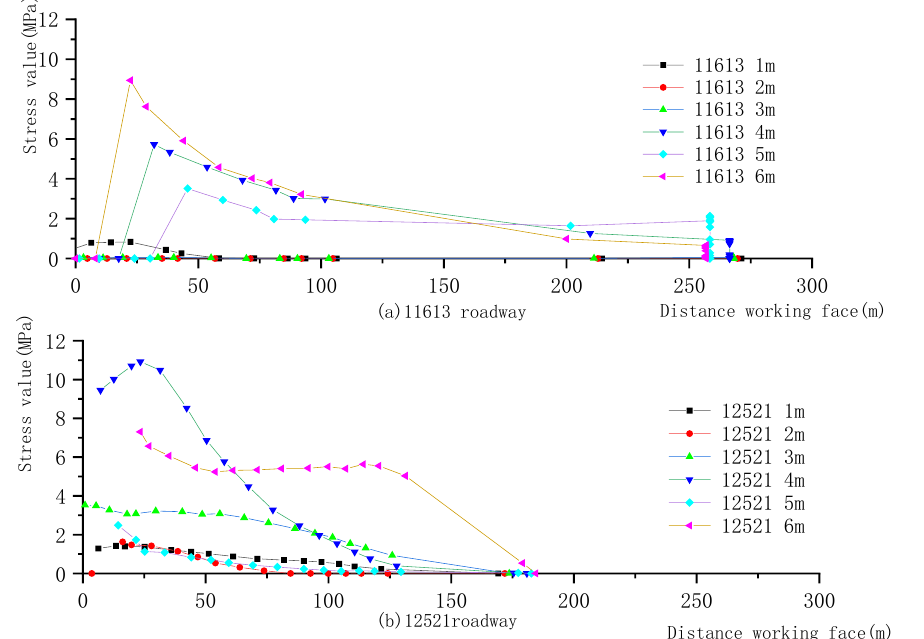
Figure 10. Comparison analysis diagram of horizontal force increment at different depth measuring points in high wall. ( a ) 11613 roadway; ( b ) 12521 roadway.